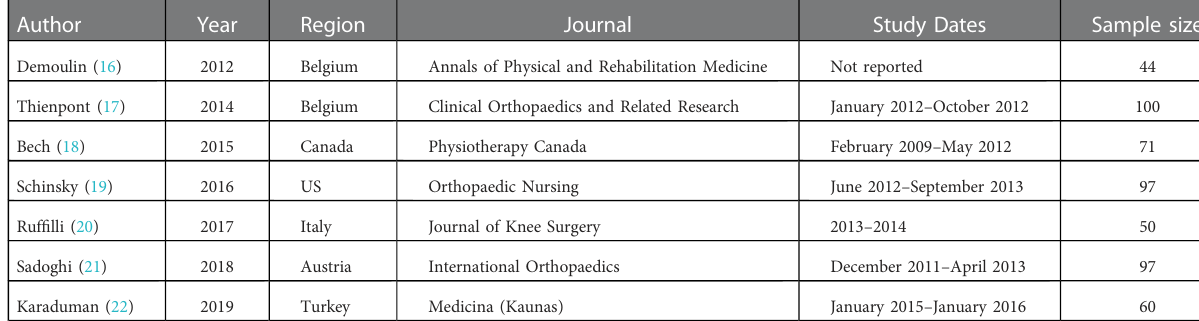
TABLE 1 Baseline characteristics of the included